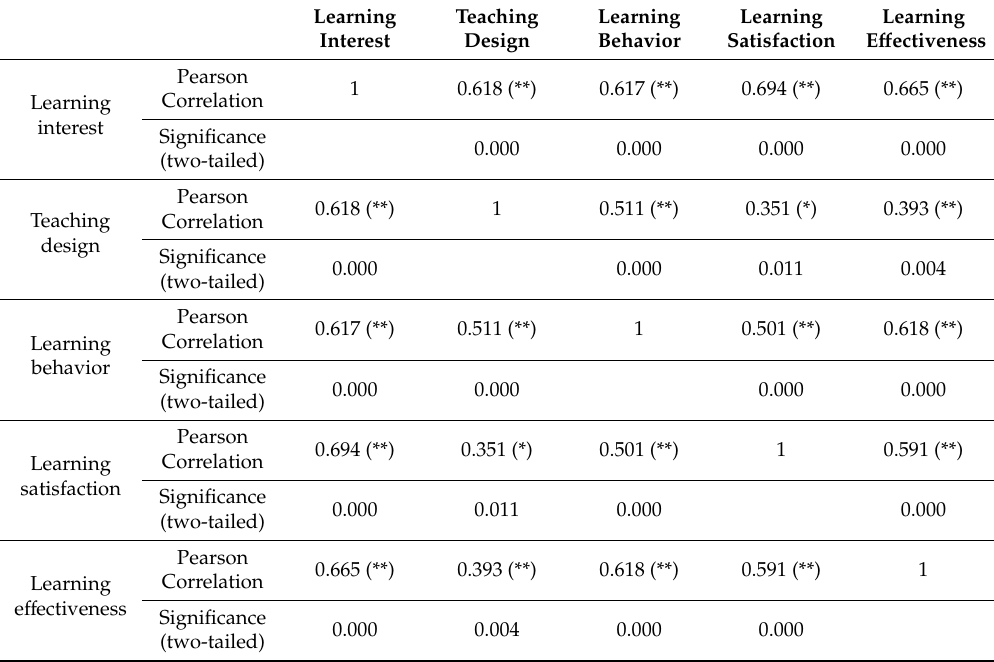
Table 8. Correlation